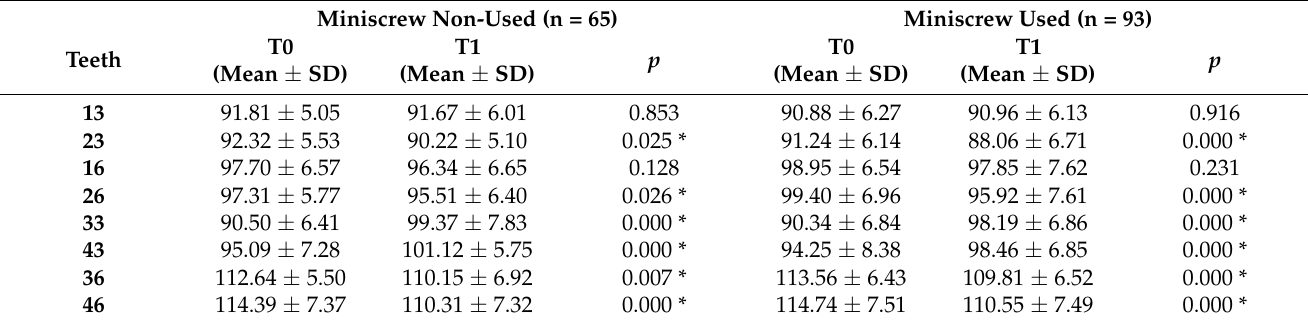
Table 8. Results of T0/T1 angulation changes of cases used and non-used miniscrew in extraction cases. Miniscrew Non-Used (n = 65)